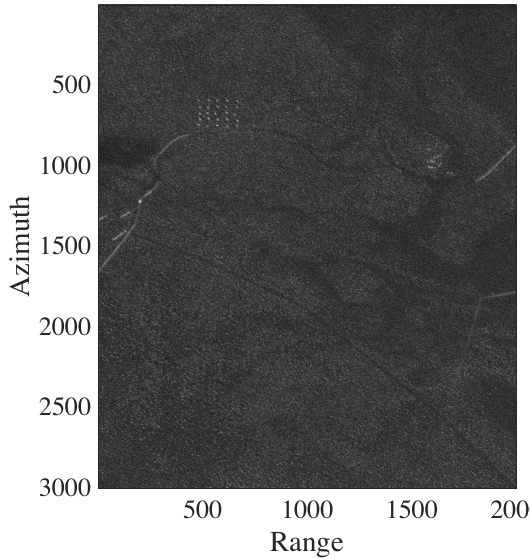
Figure 3. Sample image from CARABAS II data set—Stack 1: mission 1 and pass